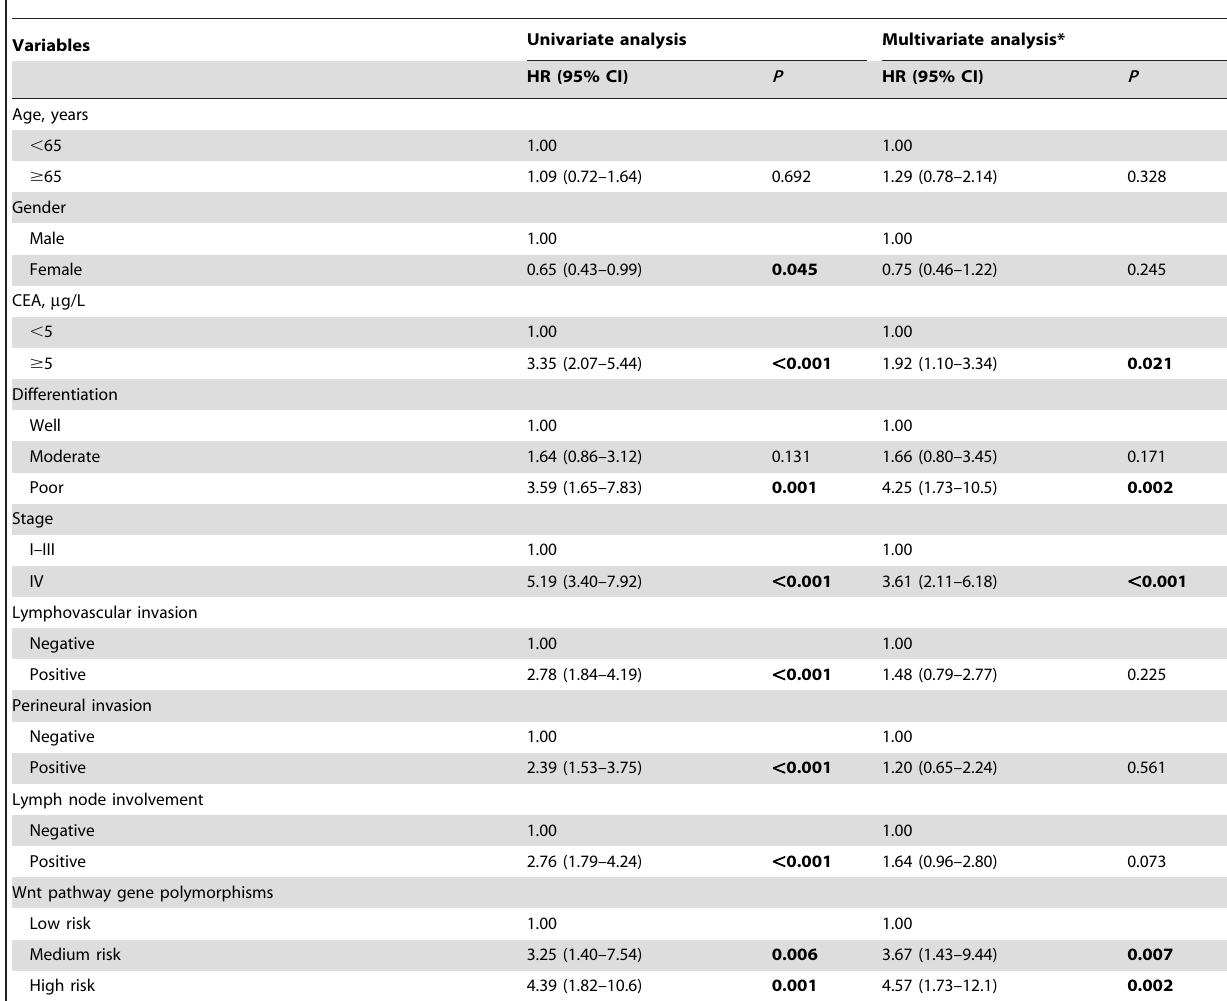
Table 2. Cox proportional hazards analysis of factors associated with overall